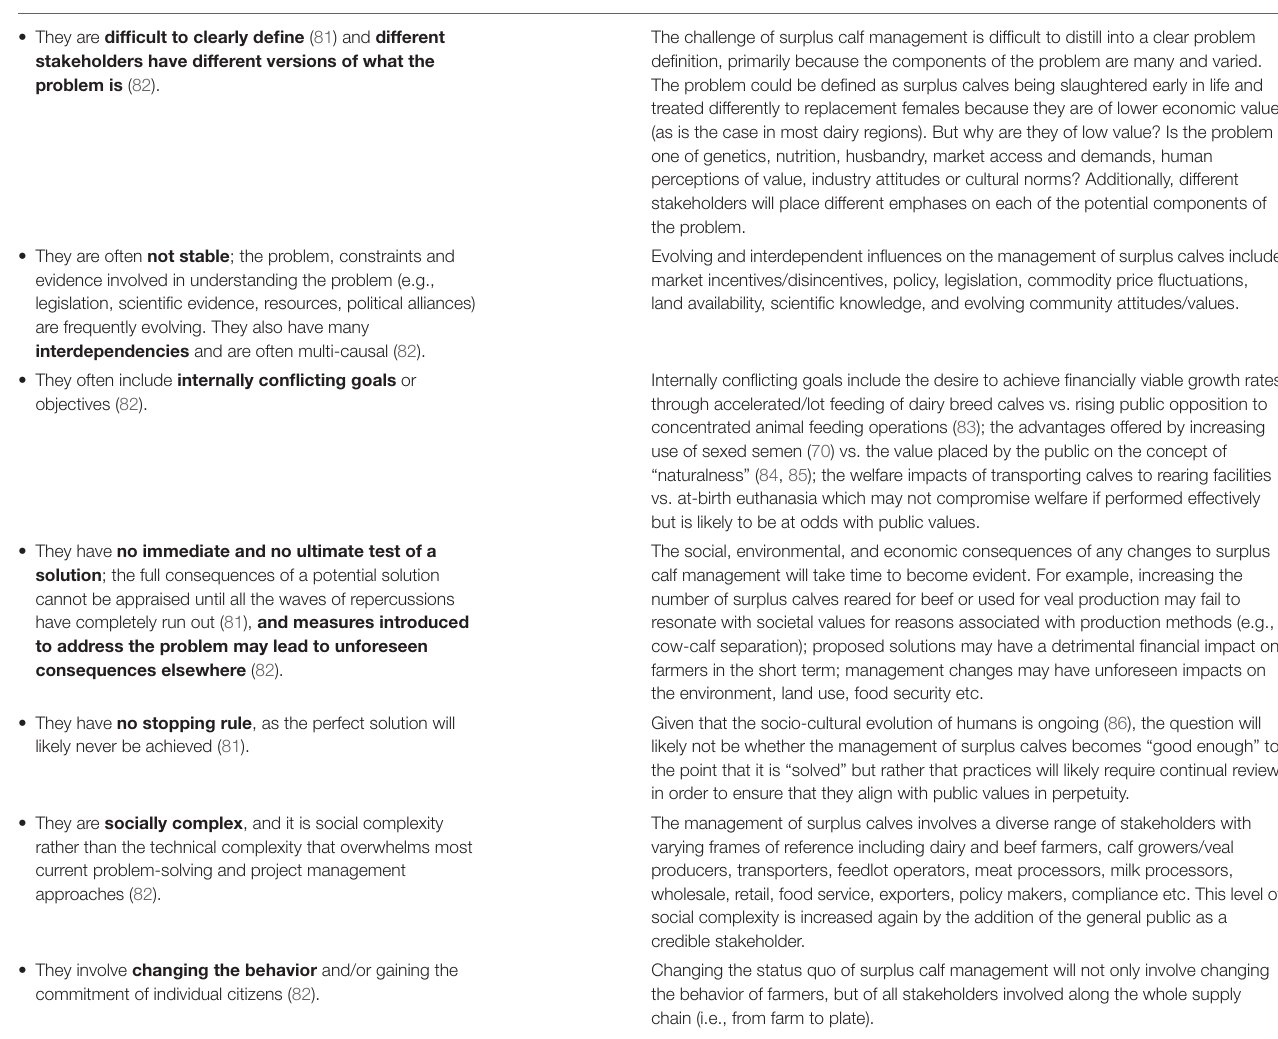
TABLE 1 | Key features of a “wicked problem” and how aspects of current surplus dairy calf management systems could be argued to meet each of the individual features that when taken together meet the criteria for a wicked problem. Features assigned to wicked